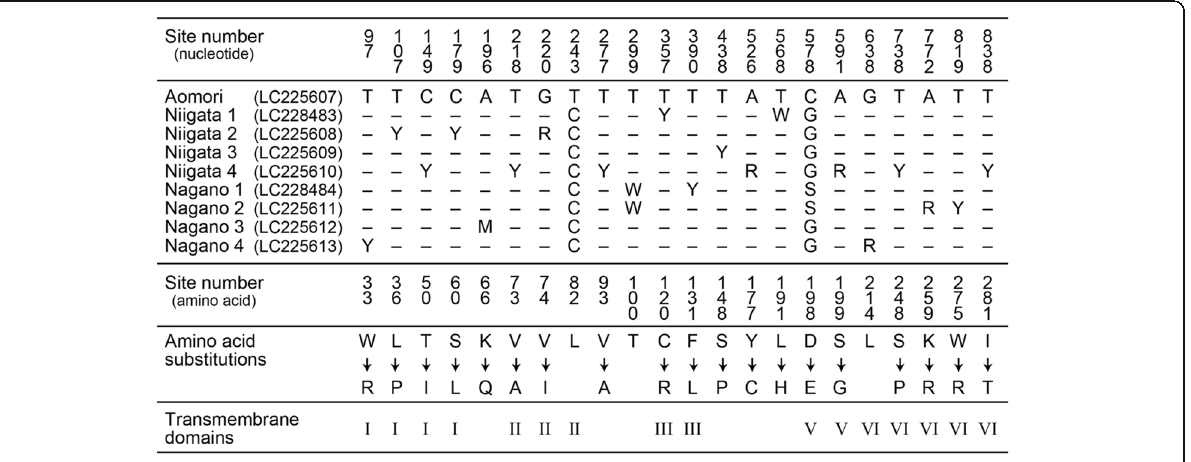
Fig. 3 Variations of nucleotide sequences detected in A. orana L opsins from nine individuals of three populations with data accession numbers. Partial L opsin nucleotide sequences of one Aomori, four Niigata, and four Nagano individuals were determined. Nucleotide variations and the resulting amino acid substitutions were shown with the site numbers. Dashes ( − ) indicate the nucleotides identical to the Aomori individual. Site numbers and trans-membrane domains were deduced based on alignment to the squid visual pigment. One-letter abbreviations for the nucleotides were following: Y for C and T, M for A and C, W for A and T, R for A and G, S for C and